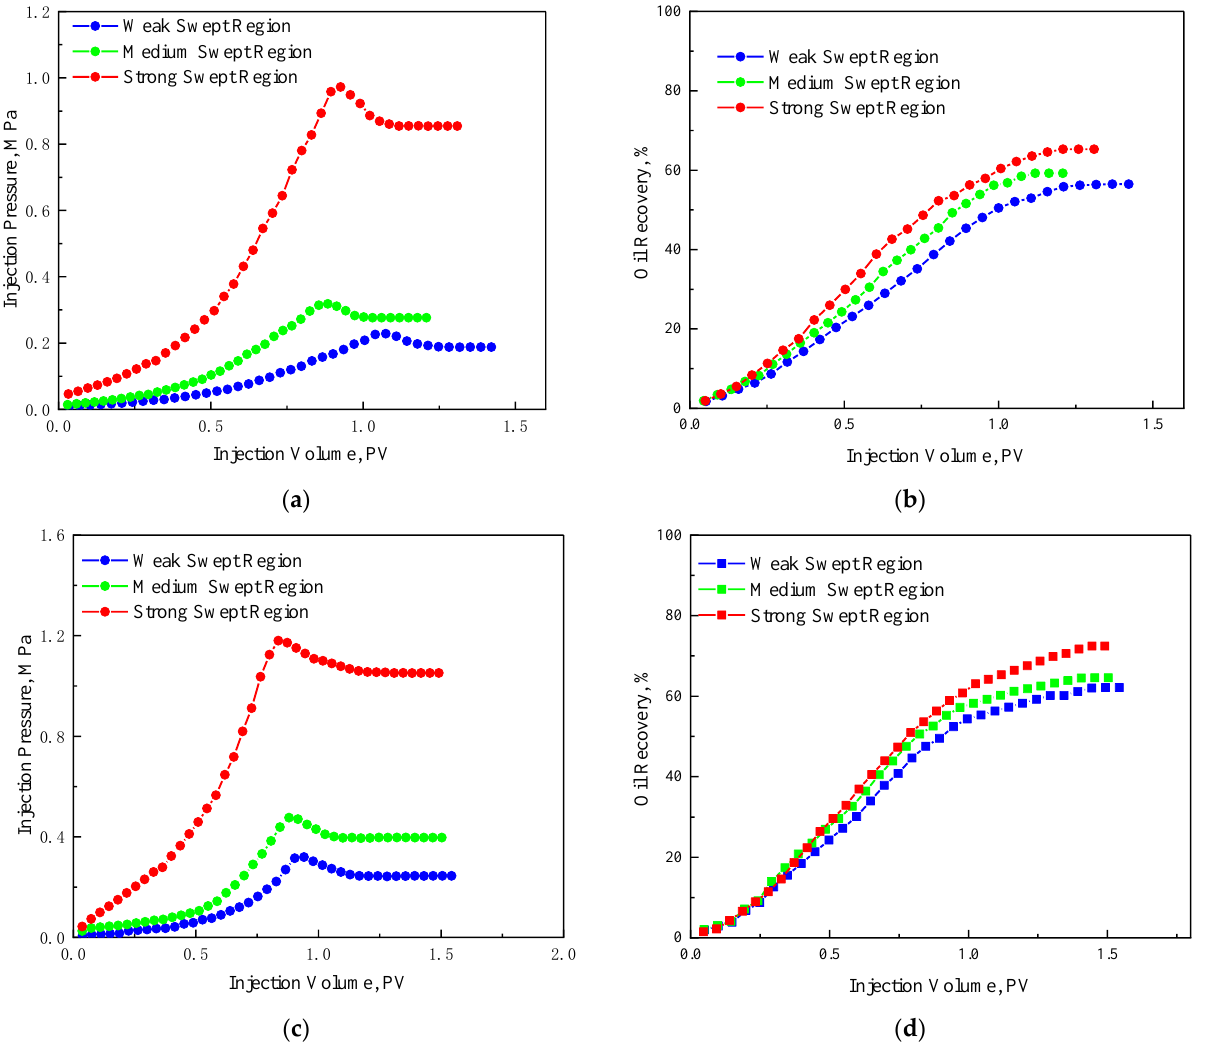
Figure 8. The injection pressure and oil recovery curves of the experiment at the core permeability is 300 mD. ( a ) Injection pressure curve with S/P viscosity is 23.5 mPa·s; ( b ) oil recovery curve with 300 mD. ( a ) Injection pressure curve with S/P viscosity is 23.5 mPa · s; ( b ) oil recovery curve with S/P S/P viscosity is 23.5 mPa·s; ( c ) injection pressure curve with S/P viscosity is 44.6 mPa·s; ( d ) oil recov- viscosity is 23.5 mPa · s; ( c ) injection pressure curve with S/P viscosity is 44.6 mPa · s; ( d ) oil recovery ery curve with S/P viscosity is 44.6 mPa·s. curve with S/P viscosity is 44.6 mPa ·